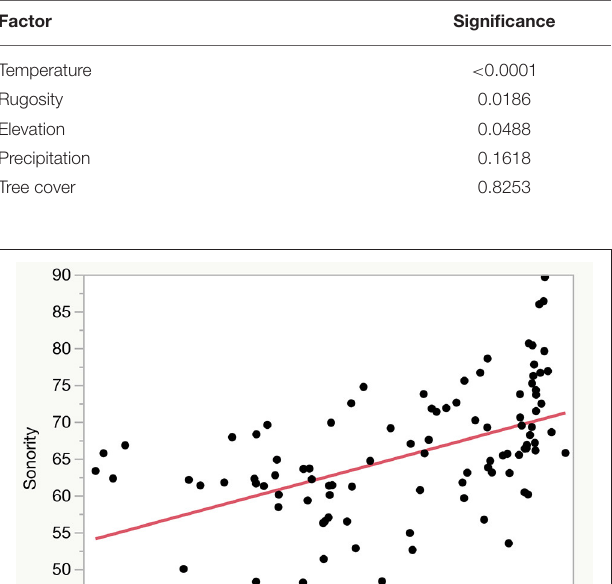
TABLE 1 | Correlations between sonority score and climatic and environmental factors.